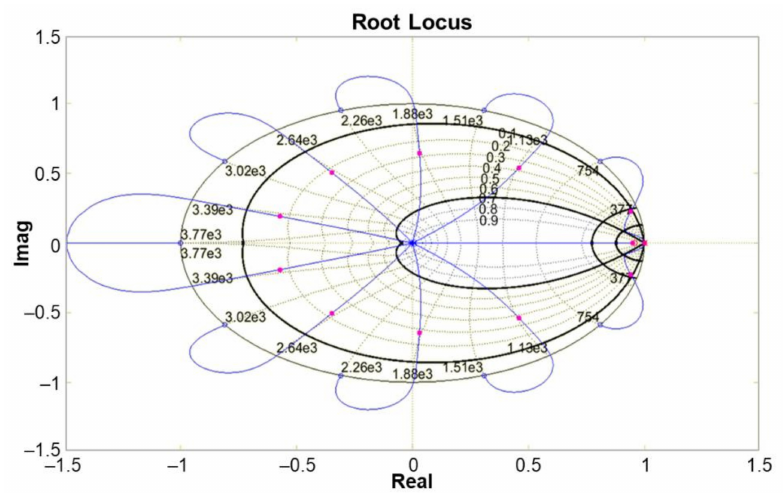
Figure 6. Root Locus of the MA-PLL ( N = 10, f c = 120 Hz, and f a = 1200